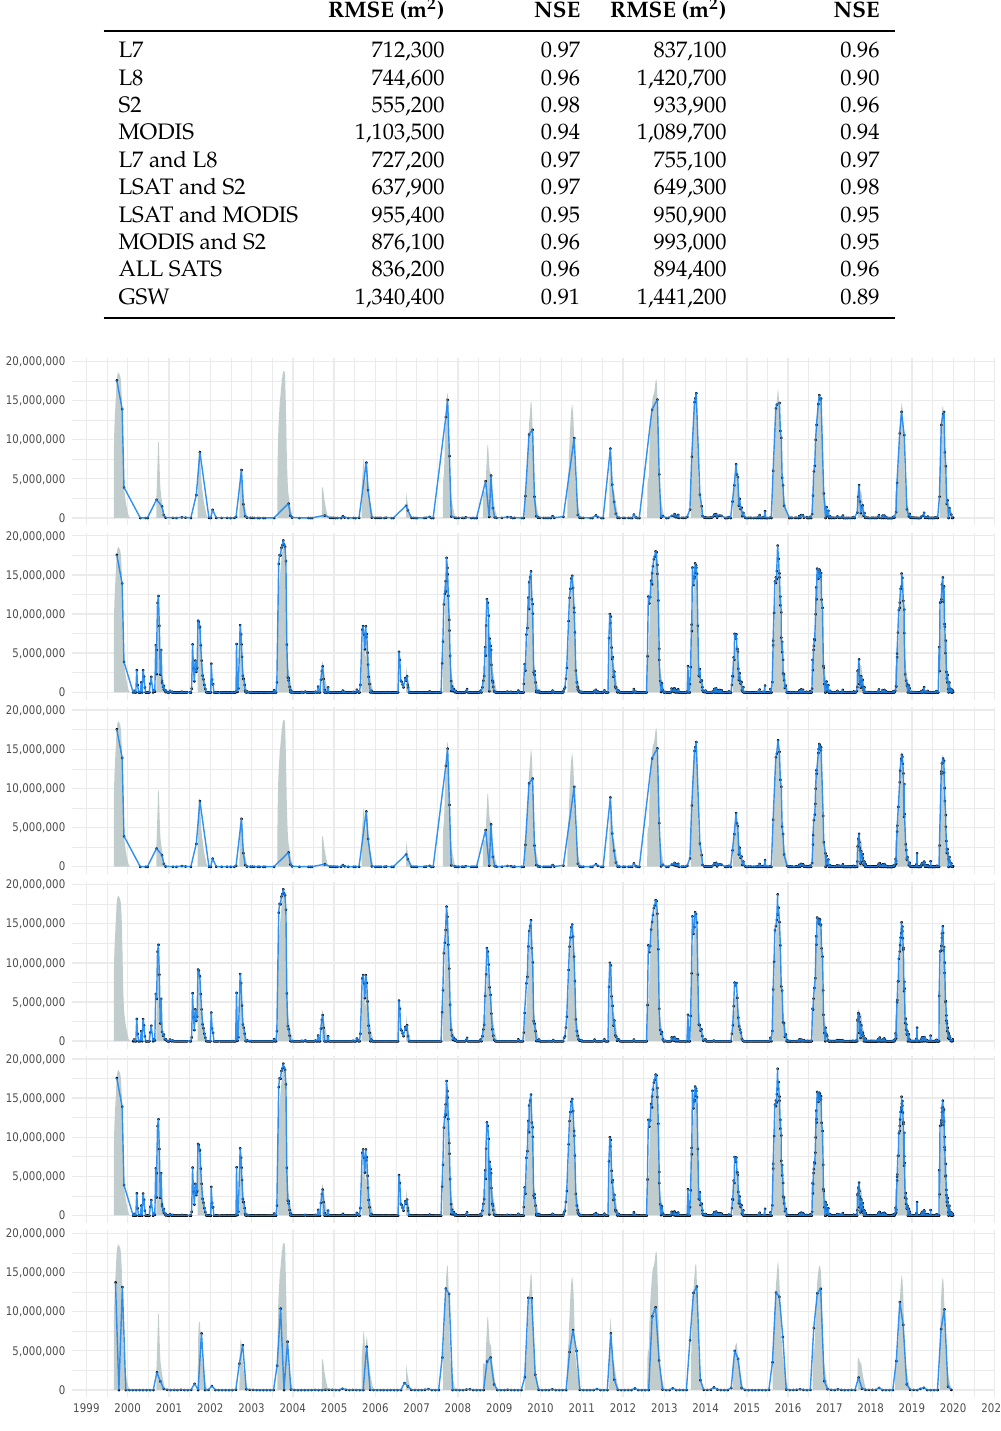
Figure 14. Comparison of multi-sensor remotely sensed flooded areas with the optimal MNDWI classification method and from Global Surface Water datasets (blue lines) against ground truth data (grey areas)